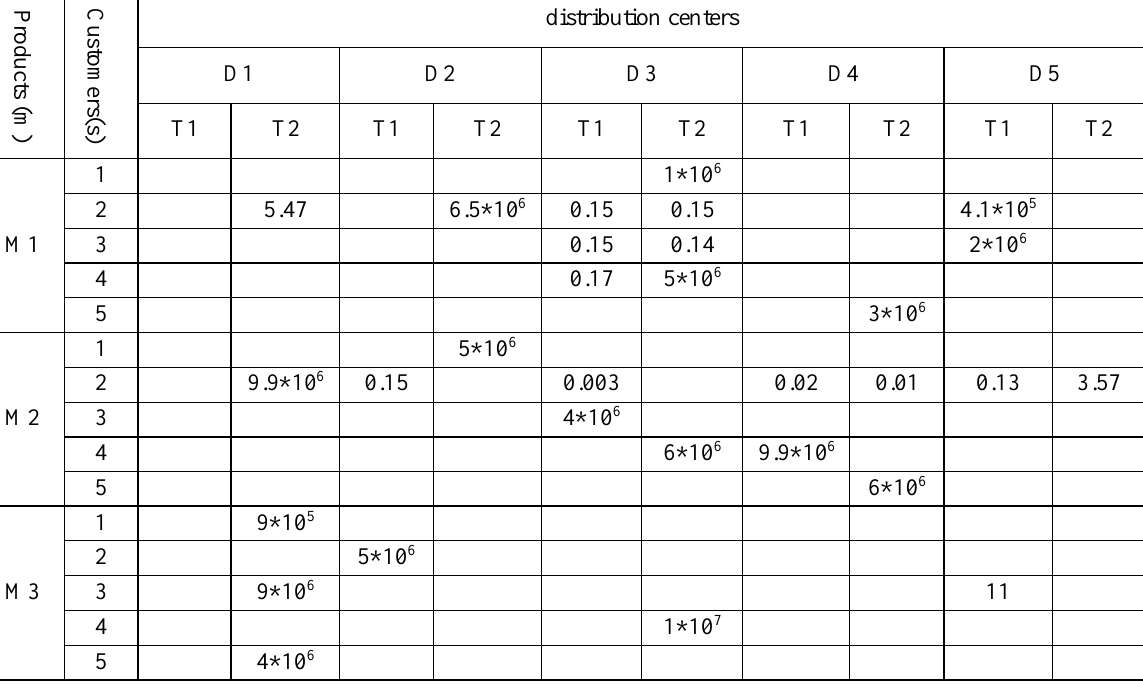
Table 11- Amounts of products sent from the distribution centers to the customer